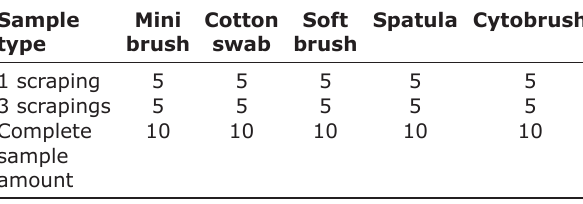
Table-1: Number of cytology samples per